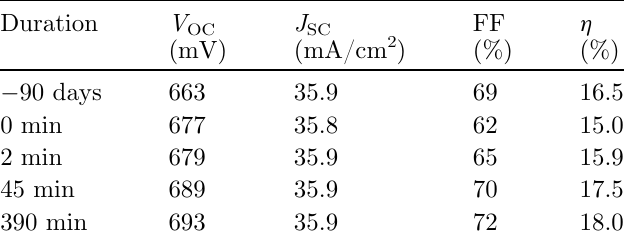
Table 5. PV parameters of best performing device before and after light soaking at 1 sun, measured 90 days after fi nishing the